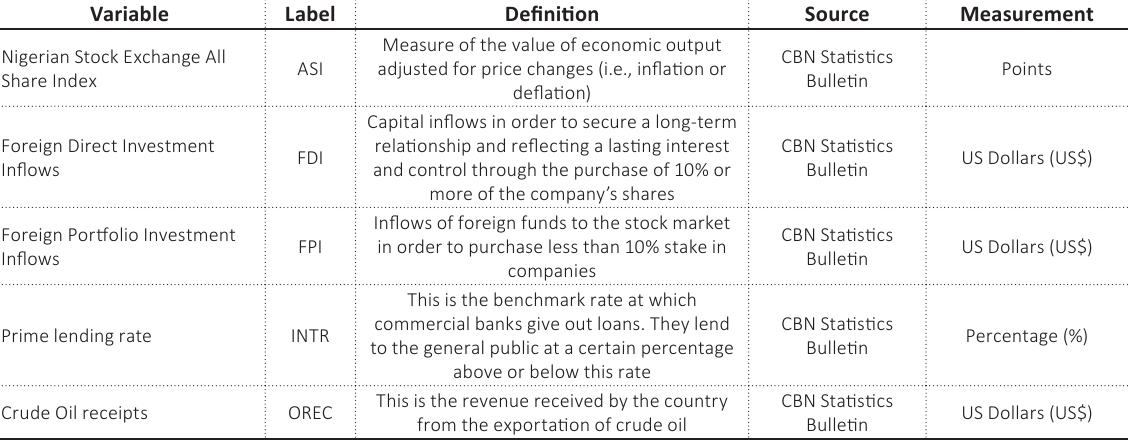
Table 1. Description of variables